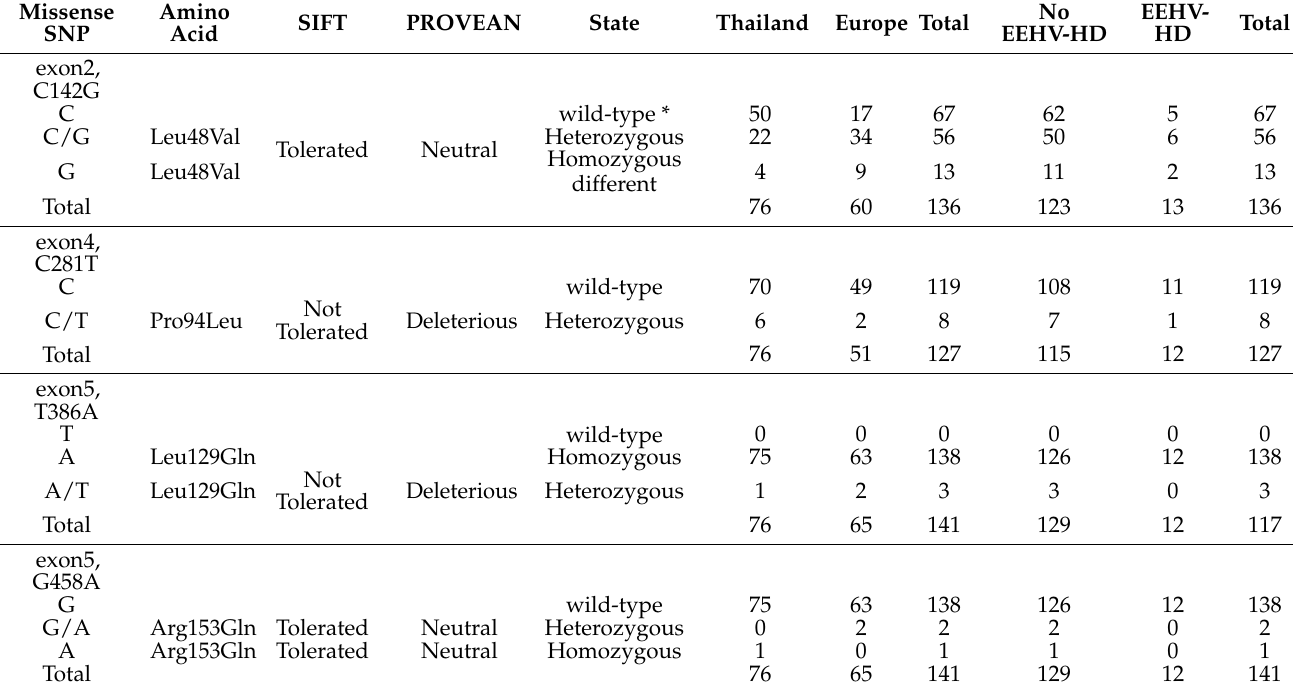
Table 4. Distribution of the missense mutations found, by region, by non-EEHV symptomatic elephants and EEHV-HD symptomatic calves. Prediction of aa substitution and its impact on the biological function of the protein tested are presented for both PROVEAN and SIFT